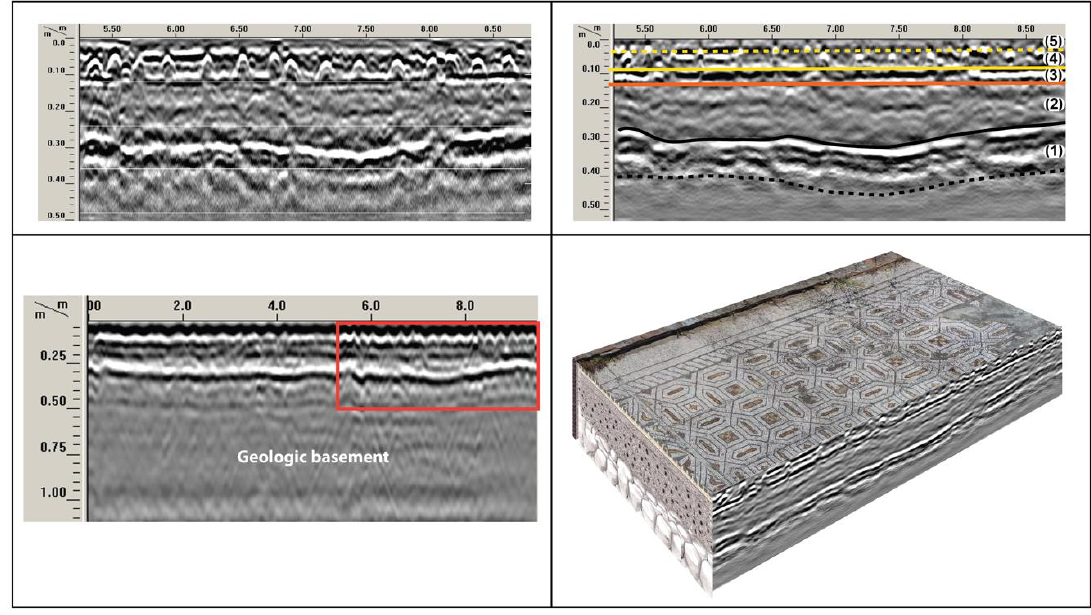
Figure 11. Top images show a 2D-GPR profile acquired with a 1600 MHz antenna, and the processing flow that was applied to this profile, as represented in Table 2. The right radargram di ff ers from the left radargram because a Kirchho ff migration has also been applied. In both radargrams, we can distinguish all mosaic units (see the main text). The bottom left image is a raw 2D-GPR profile acquired with a 400 MHz antenna. The profile shows a general vertical stratigraphy view of the mosaic over the geologic bed. The red target indicates the location of the 1600 MHz 2D-GPR profile shown in the upper panel. The bottom right image is a general interpretation view of the main inner structure of the